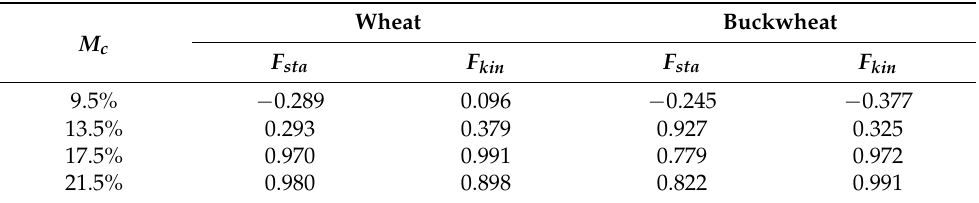
Table 3. Correlation factors ( R 2 ) of the force of static and kinetic friction with the number of contact points for particular levels of moisture.